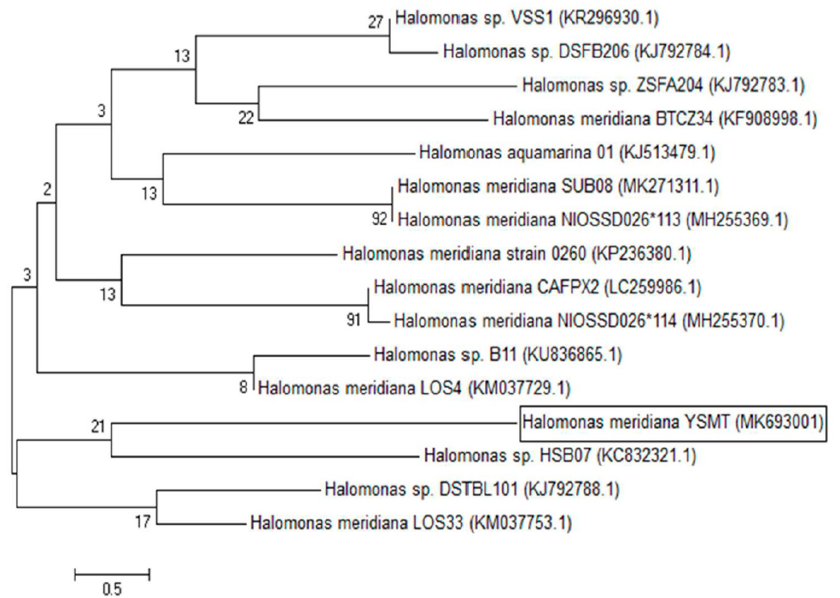
Figure 2. Phylogenetic tree of the Halomonas meridian isolate and other related strains with their accession numbers in brackets. MEGA 5.1 program was used to construct the branching pattern through the neighbor-joining tree method with 1000 bootstrap.